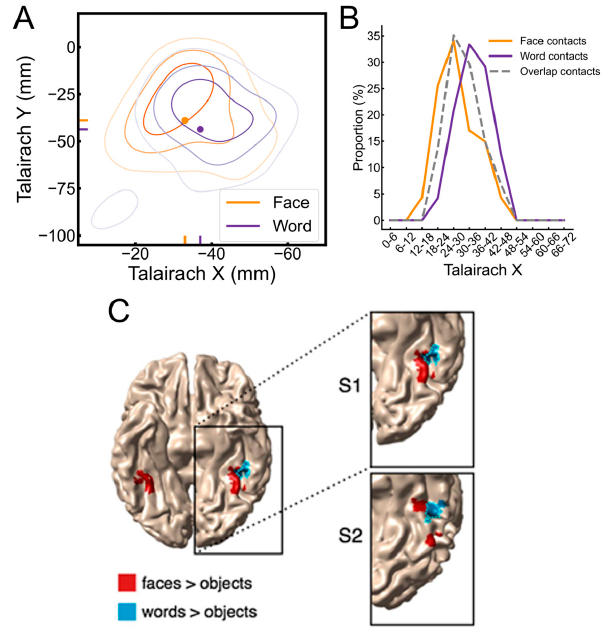
Figure 15. Spatial distribution of word- and face-selective responses in the left hemisphere [168]. ( A ) Left: contour plot showing the distribution of face- and word-selective SEEG contacts in the left hemisphere along the medio-lateral (Talairach X) and posterio-anterior axes (Talairach Y). Each distribution is normalized relative to itself, and darker contour colors indicate a larger density of contacts. The central mass for each distribution is plotted as a solid dot within the contour plot and as a vertical/horizontal line on the x - and y -axis. ( B ) X coordinates (medio-lateral) of the word- and face-selective contacts in core regions for neural processes supporting visual word and face recognition (IOG, FG + sulci). Word-selective responses in the fusiform gyrus are slightly more lateral on average, as also found in fMRI in neurotypical individuals (illustrated in ( C ), from [171]).